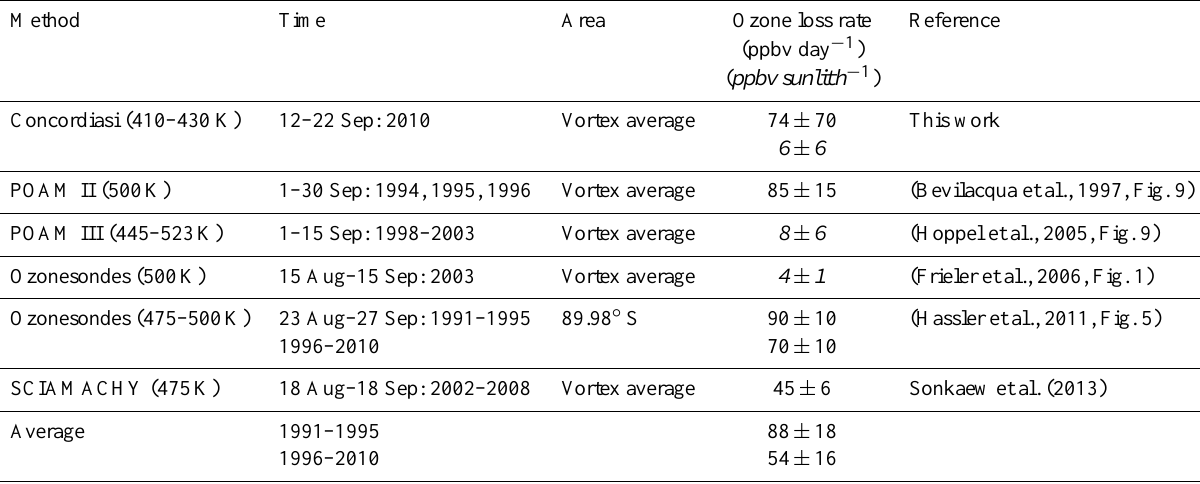
Table 2. Comparison of Antarctic stratospheric ozone loss